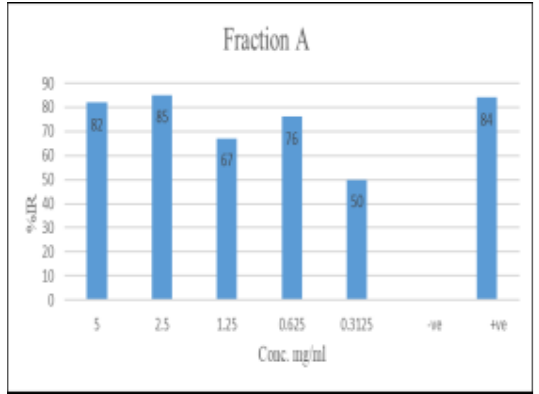
Figure 5. %IR for aerial maceration petroleum ether fraction (A) dilutions (M\G\PE)